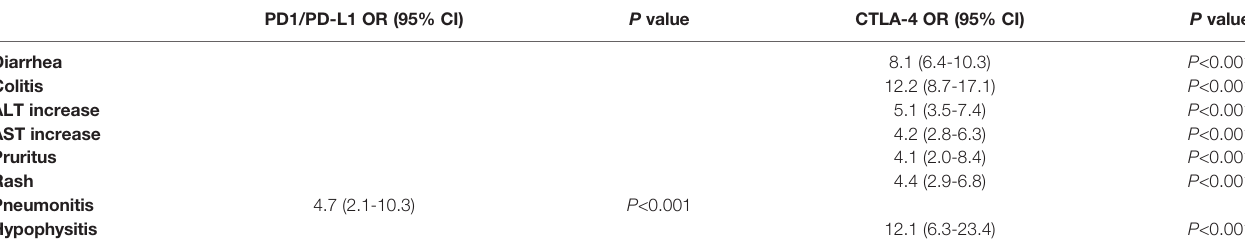
TABLE 5 | Comparison of grade ≥ 3 trAEs between CTLA-4 and